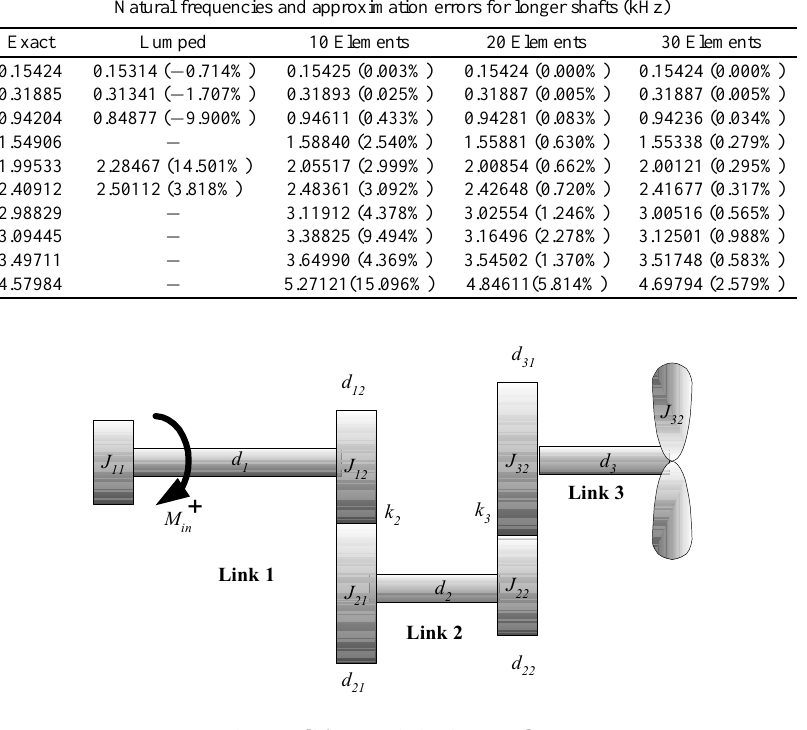
Fig. 11. 3 link transmission in Example